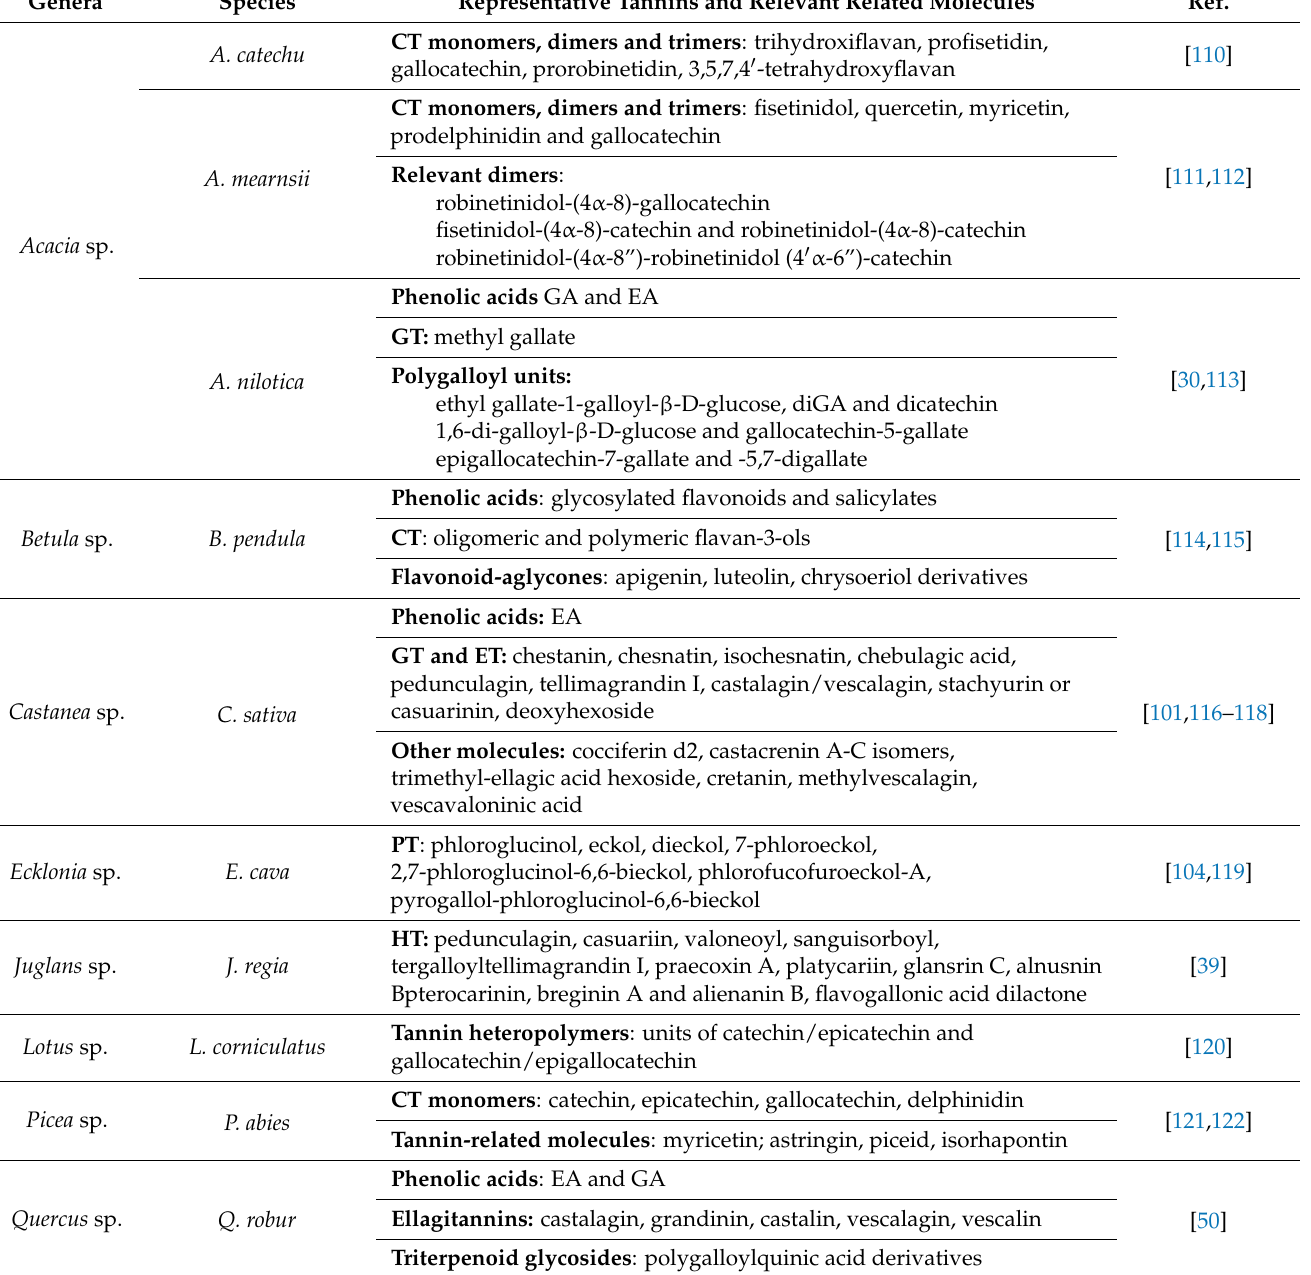
Table 2. Rich-tannins species of plant and macroalgae with the main tannin and tannin-based compounds.